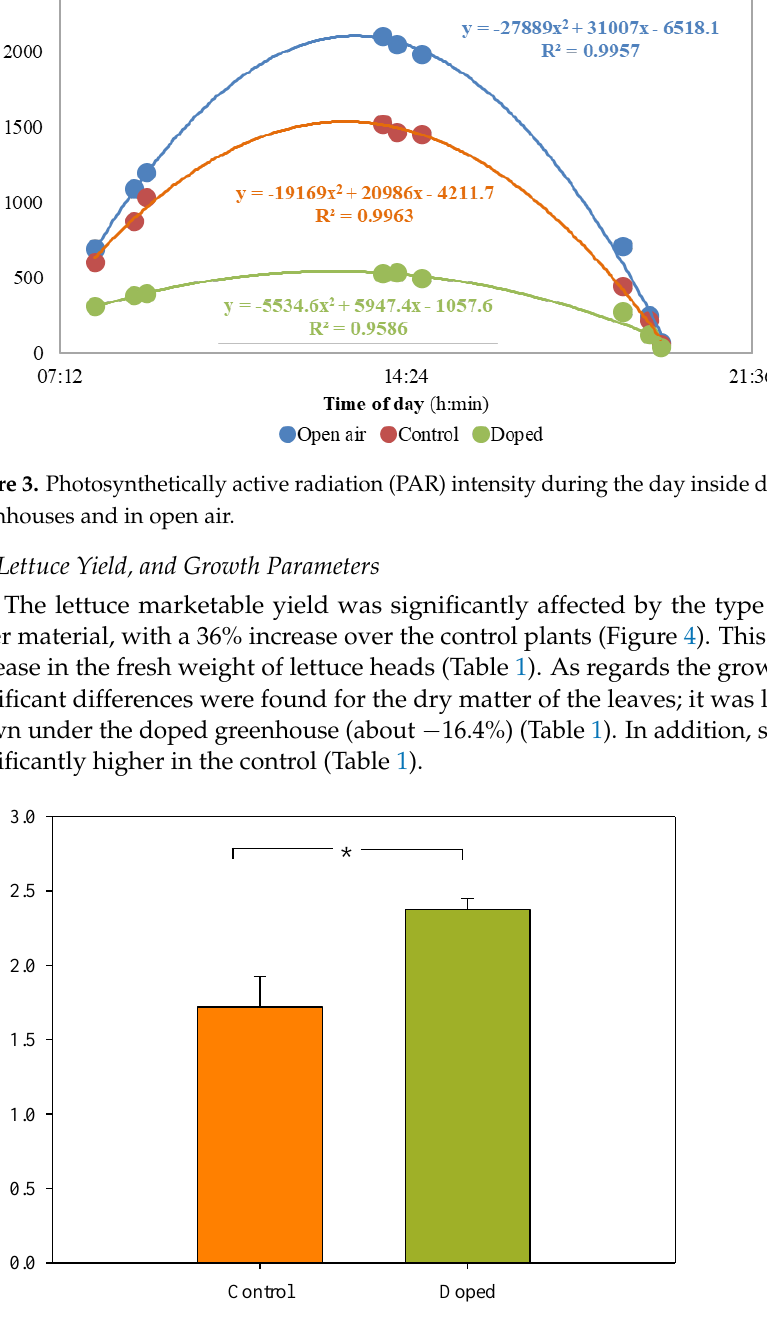
Figure 4. Marketable yield of lettuce. Vertical bars indicate mean ± standard error. * significant at p ≤ 0.05.